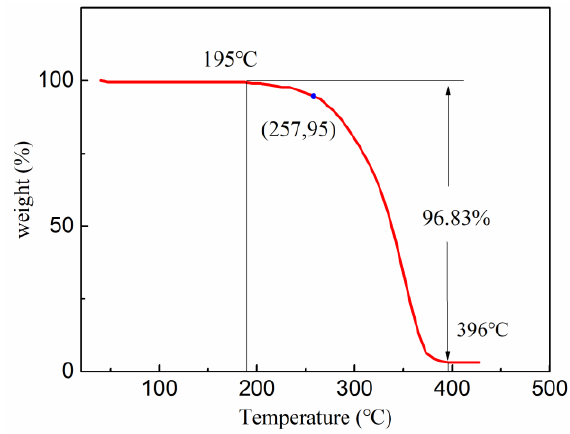
Figure 2. Thermogravimetric curve of TQ-1.